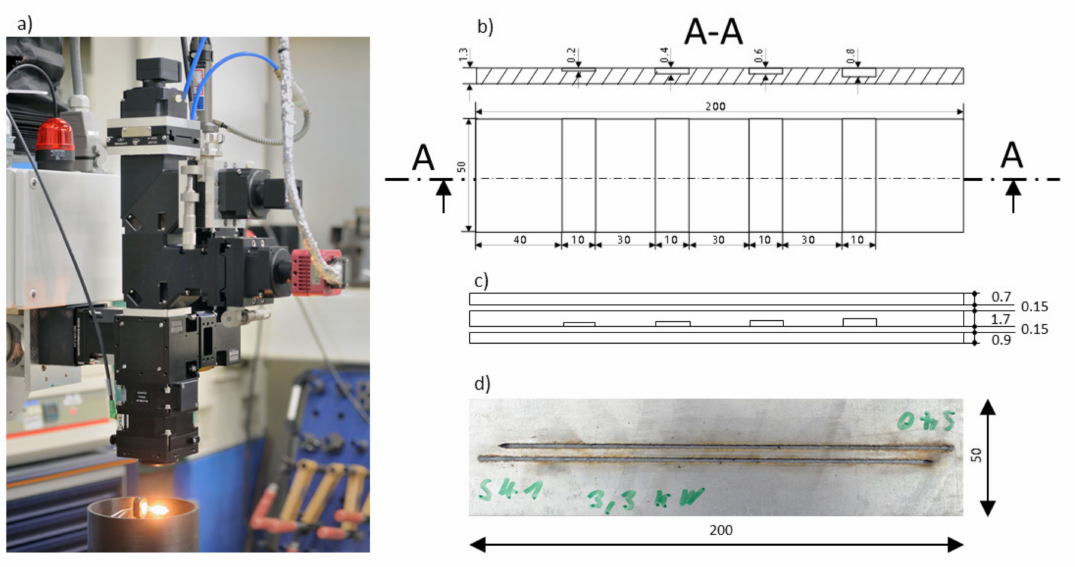
Figure 3. ( a ) Photograph of the welding optics with coaxially integrated cameras; ( b ) Drawing of welding sheets with different slot sizes (middle sheet); ( c ) Side view of the sheet configuration used during the welding experiments; ( d ) Photograph (top view) of two welding trails (P = 3.3 KW, v = 50 mm/s, ds = 0.6 mm, Argon shield gas flow = 60